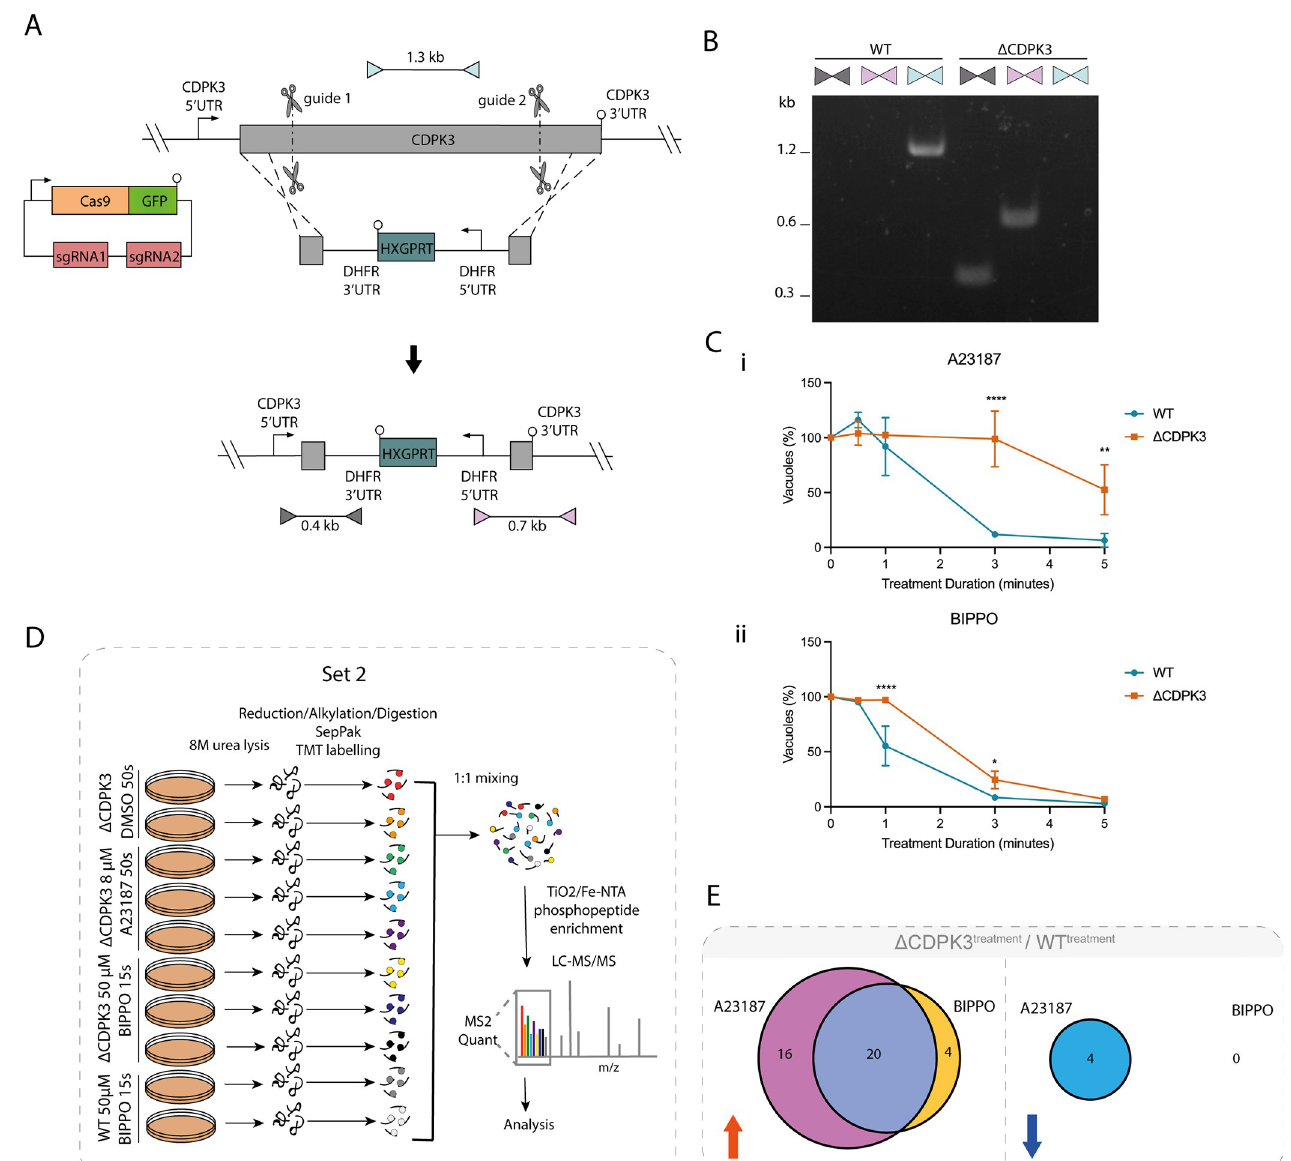
Fig 2. Comparative phosphoproteomics of BIPPO vs A23187-induced GFP-T2A-jRCaMP1b Δ CDPK3 parasites at peak cytosolic calcium levels (A) Generation of the GFP-T2A-jRCaMP1b Δ CDPK3 line using CRISPR/Cas9 to increase site-directed integration. Scissors represent Cas9 cleavage sites and lollipops depict stop codons. Coloured triangles represent primer pairs used to detect WT, 5’ integration and 3’ integration loci (light blue, grey and pink respectively). (B) PCR results using the primer pairs shown in Fig 2A (C) Egress assay of GFP-T2A-jRCaMP1b (WT) and GFP-T2A-jRCaMP1b Δ CDPK3 ( Δ CDPK3) parasites following treatment with (i) 8 μ M A23187 or (ii) 50 μ M BIPPO. Graph shows the remaining % of un-egressed vacuoles (relative to untreated) following A23187/BIPPO treatment. Data are represented as mean ± s.d. (n = 3). Two-way ANOVA with Holm-Sidak post hoc comparison. ���� , P � 0.0001 (D) Schematic summary of the TMT-10-plex experiment (set 2) and workflow used to quantify the phosphoproteomes of intracellular Δ CDPK3 tachyzoites treated with 50 μ M BIPPO (15s), 8 μ M A23187 (50s), and WT parasites treated with 50 μ M BIPPO (15s). (E) Overlap between differentially regulated phosphosites that display CDPK3 dependency following treatment with 50 μ M BIPPO (15s) or 8 μ M A23187 (50s) (data derived from set 1 and 2). Red and blue arrows represent up- and down-regulated sites, respectively. Only phosphosites found to be differentially regulated upon treatment with both A23187 and BIPPO were included for